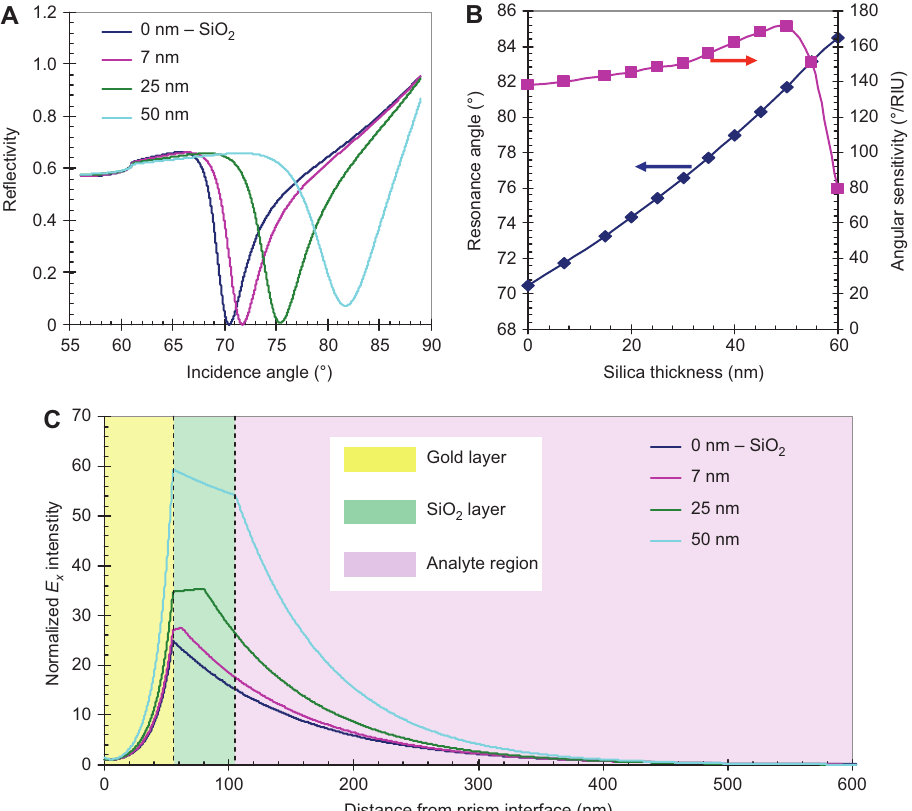
Figure 7 (A) Refl ectivity response for different SiO overlayer thicknesses; (B) change of angular sensitivity (pink) and resonance angle x overlayer thickness; (C) E fi eld intensity distribution normalized to the incident intensity as a function of the distance (blue) vs. the SiO x x layer thicknesses; parameters used for calculations: n from prism interface for different SiO x = 1.48, n = 2.32 + 3.08i, d = 5 nm. n silica Ti Ti